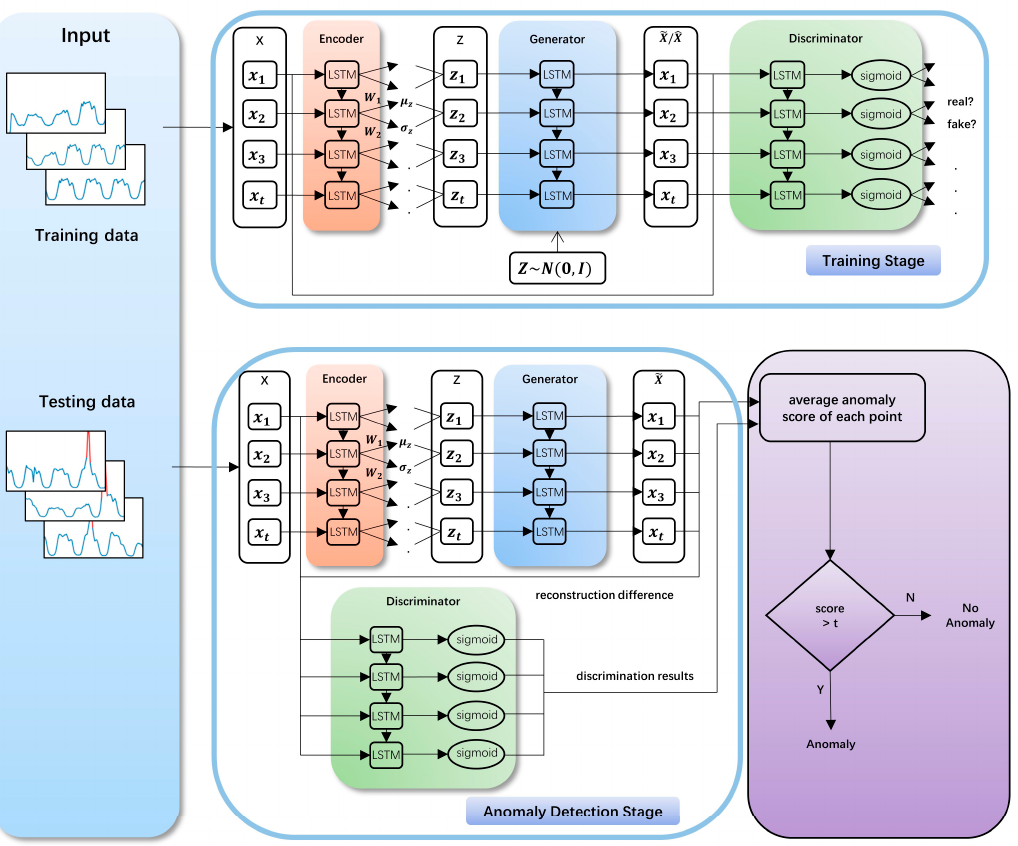
Figure 2. LSTM-based VAE-GAN architecture. µ z and σ z are obtained by the linear transformation of the encoder output. W 1 and W 2 are the coe ffi cients of the linear transformation. z = µ z + σ z (cid:12) (cid:15) , where (cid:15) ∼ N ( 0, I ) and (cid:12) signify an element-wise